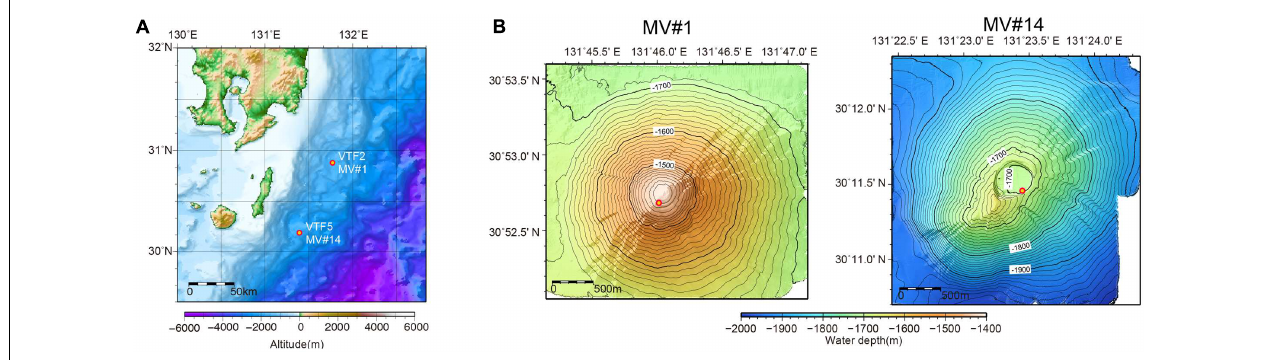
FIGURE 1 | (A) Location of submarine mud volcanoes (SMVs) MV#1 and MV#14 along the Ryukyu Trench near Tanegashima Island, Japan. (B) Detailed bathymetric maps of MV#1 and MV#14. Both SMVs are about 3000 m in diameter and 300 m in height. The yellow circles indicate sampling points.